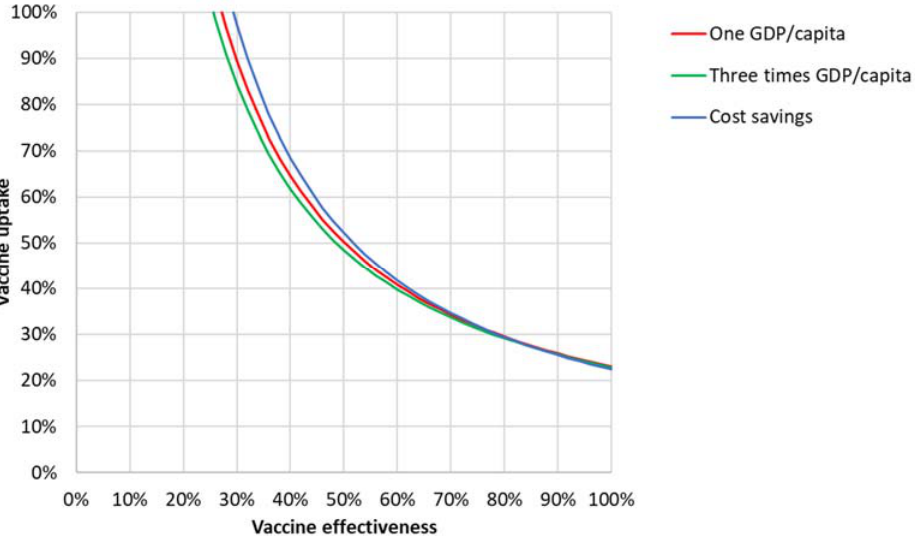
Figure 2. Iso-ICER curves from the societal perspective for one GDP/capita, three-times GDP/capita, and achieving Figure 2. Iso ‐ ICER curves from the societal perspective for one GDP/capita, three ‐ times GDP/cap ‐ ita, and achieving cost savings. cost